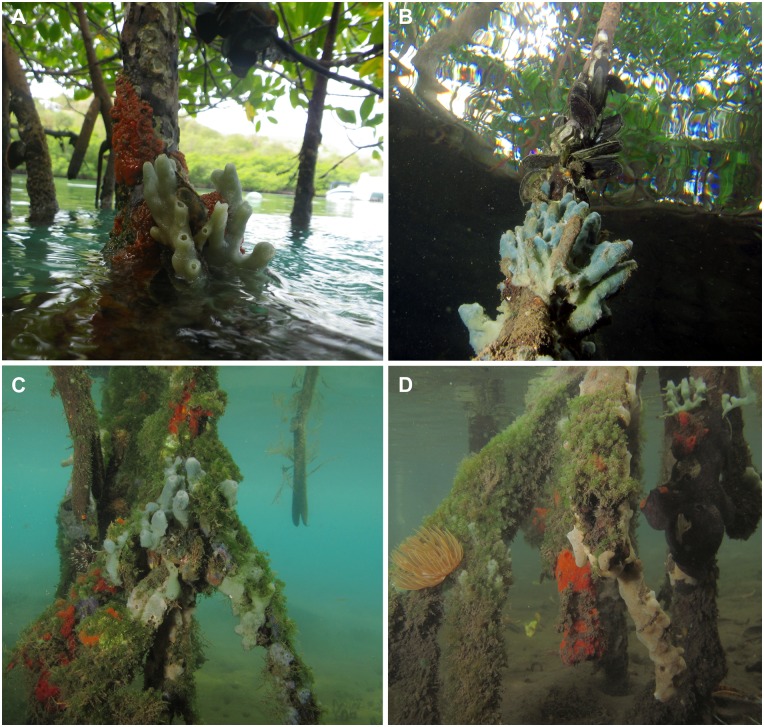
In situ photographs of the sponge community growing on mangrove roots in Martinique.A) Tedania ignis (the fire sponge) and Haliclona caerulea both exposed at low tide. B) Submerged specimen of Haliclona caerulea, above a mussel aggregate, and the air exposed zone of the red-mangrove root. C) Green algae (Caulerpa sp.), Haliclona caerulea and patches of Tedania ignis. D) Large root covered by algae, except areas where Spirastrella mollis and patches of Tedania ignis are seen. Picture A by C. Díaz and pictures B,C,D by T. Pérez.